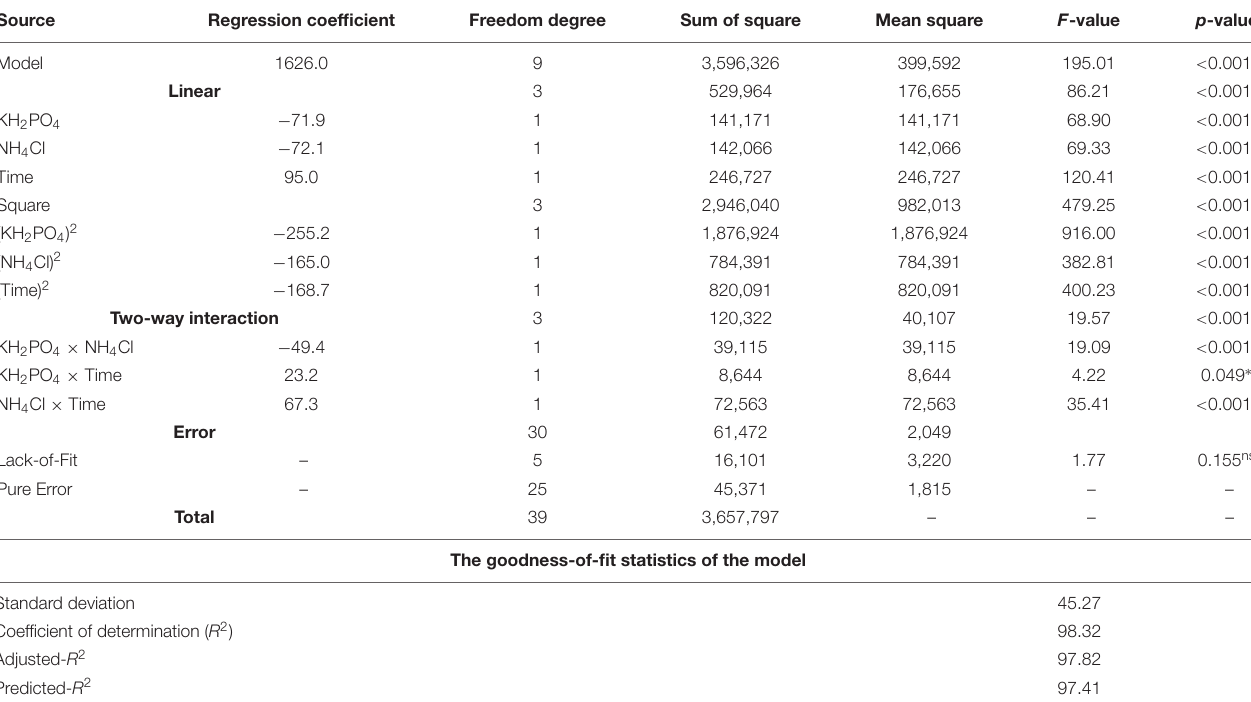
TABLE 3 | The statistical analysis of the RCCD data of amino acids, generated by B. paramycoides ZW-5, shows the coded regression coefficient and ANOVA. Source Regression coefficient Freedom